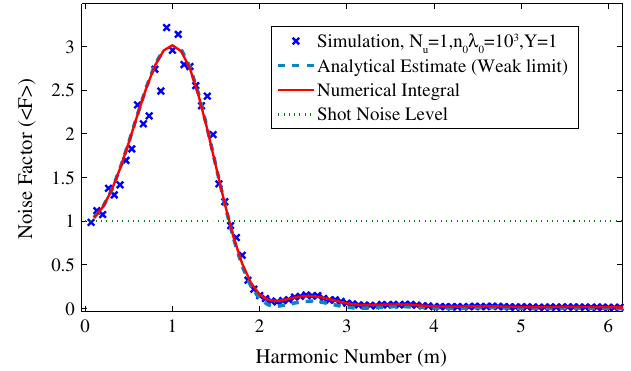
FIG. 7. A comparison of simulation, analytical result and numerical integral shows noise suppression at high frequency for (cid:2) ¼ 1 . At low frequencies ( m (cid:4) 1 ), we find ~ h u ð k Þ is ap- proximately real [Eq. (31)], and bunching increases to F ð k Þ (cid:6)